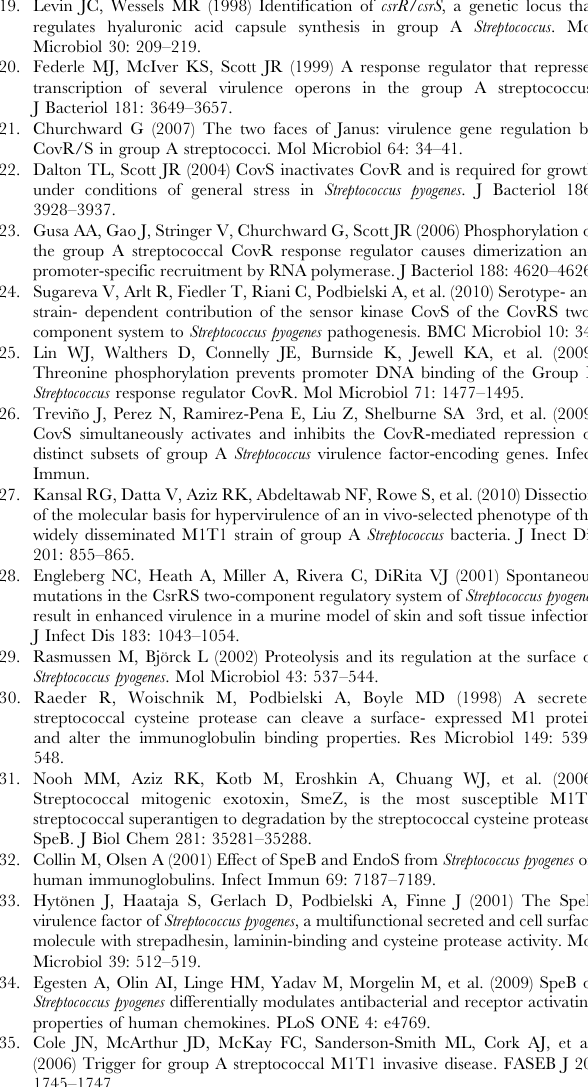
Table S1 All array data used to generate the pathovivogram (Figs. 2 and S2).